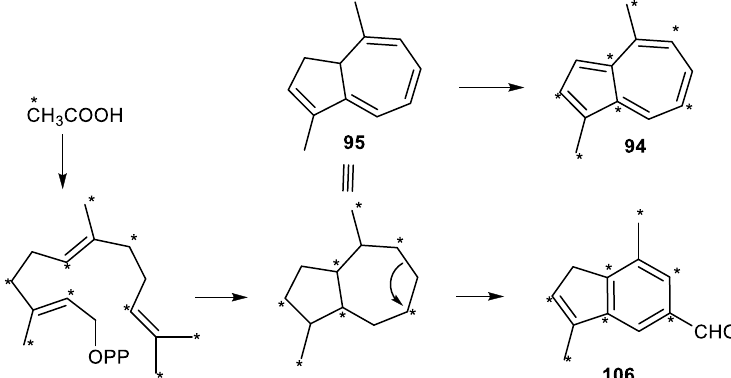
Figure 17. Incorporation of 13 C from [2- 13 C]-labeled acetate into compounds 94 , 95 and 106 (adapted from Takeda and Katoh 1983b [272]).